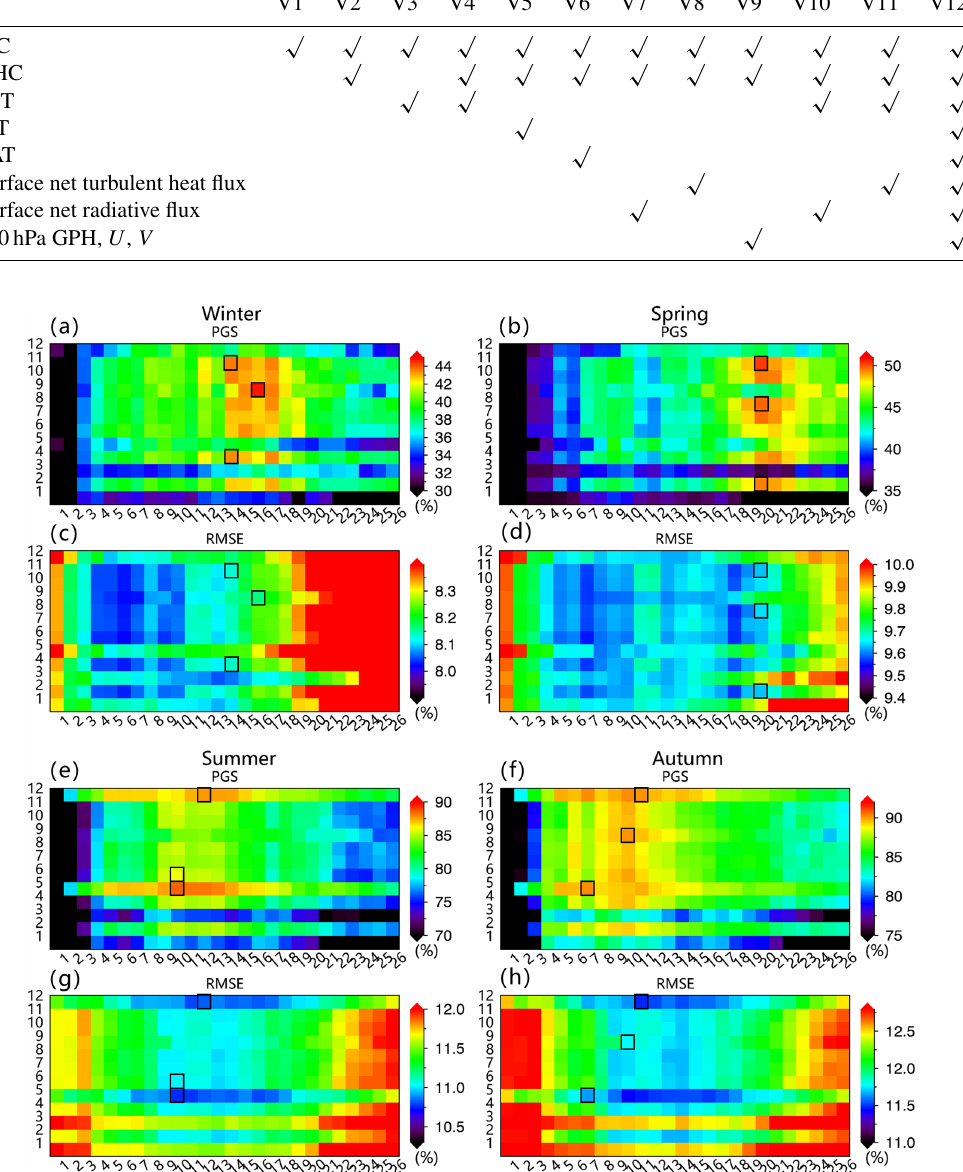
Figure 3. Mean PGS and mean RMSE between the observations and predictions in four seasons. (a) Mean PGS is obtained by averaging all lead months for winter predictions. The x axis represents the number of MEOF modes, and the y axis represents the combination of the variables corresponding to Table 1. Panels (b) , (e) , and (f) are the same as (a) except for spring, summer, and autumn, respectively. Panels (c) , (d) , (g) , and (h) are the same as (a) , (b) , (e) , and (f) except for